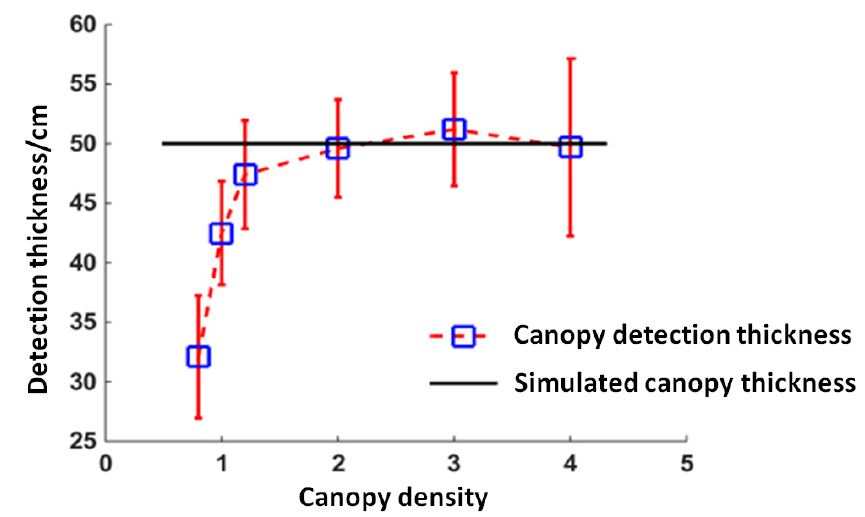
Figure 6. Canopy detection thickness curves under different densities.